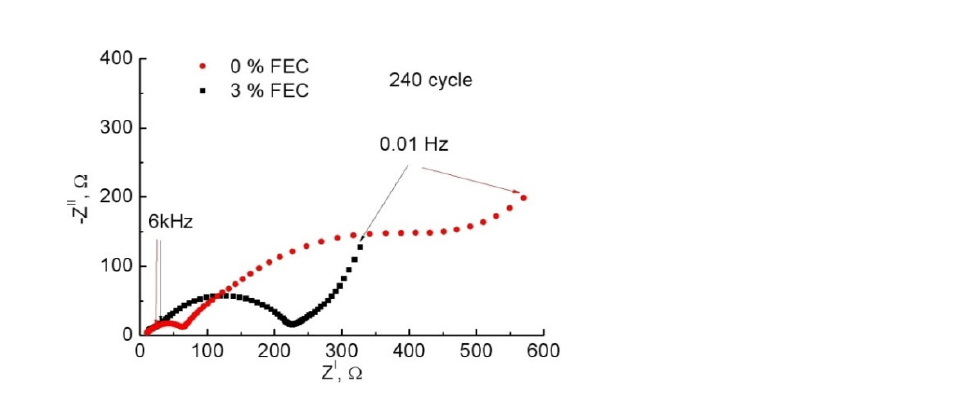
Figure 7. Impedance hodographs for the 240th charge cycle for samples with 0% and 3% FEC.